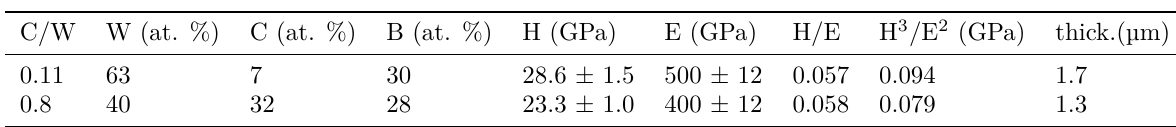
Table 1. Chemical composition and mechanical properties of the W-B-C coatings.